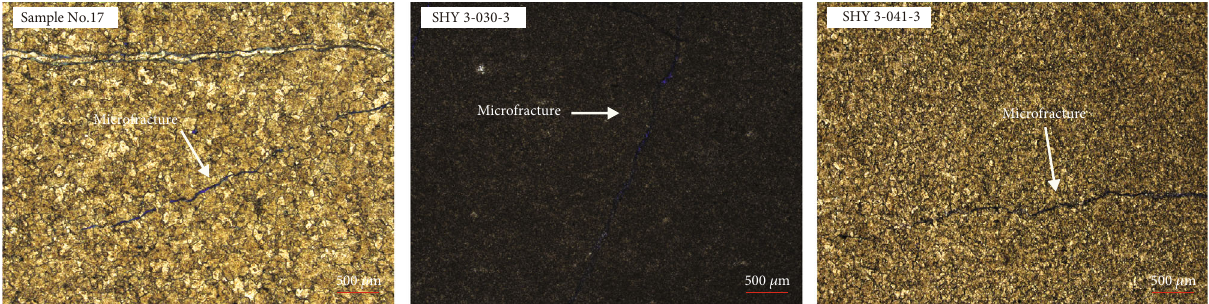
Figure 5: Observed microfractures by optical microscopy from thin sections under a polarized light.